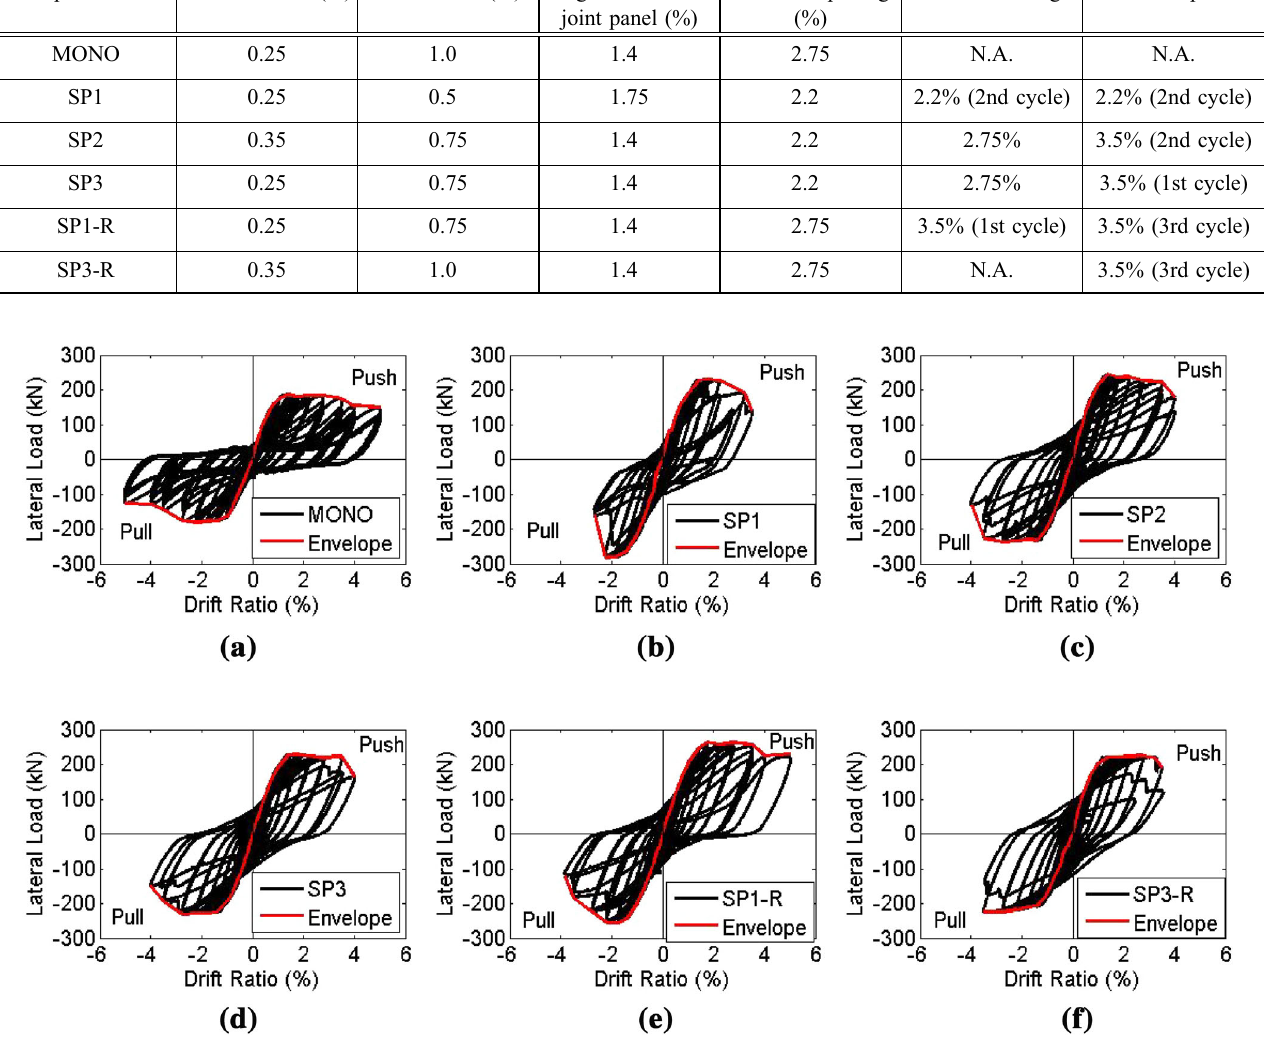
Fig. 16 Lateral load–drift ratio relationships for monolithic and precast connection specimens.